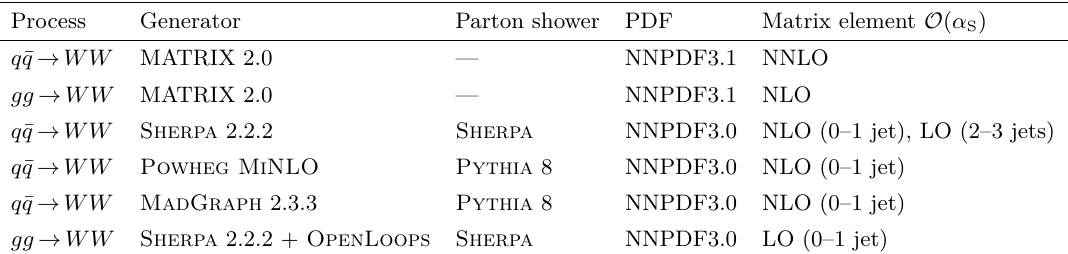
Table 7 . Summary of the theoretical predictions that are compared with the measured cross- sections. The samples generated with Sherpa use the default parton-shower tune, while for those using Pythia 8 the A14 tune and the NNPDF2.3LO PDF set are used for the parton shower.